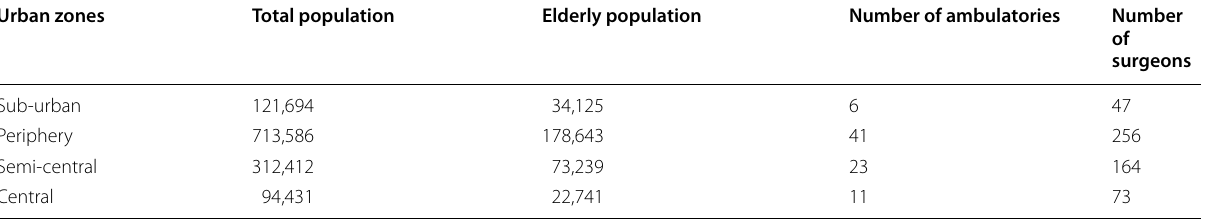
Table 1 The population and ambulatory distribution per urban zones